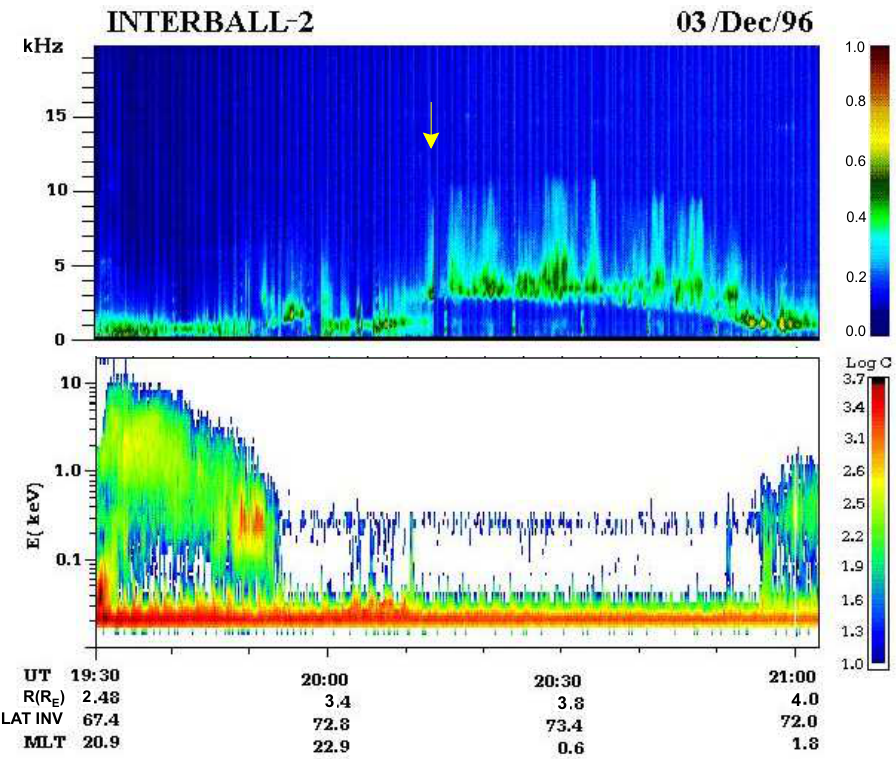
Fig. 2. INTERBALL-2 electron flux and VLF wave observations on 3 December 1996. Top panel: Spectrogram of the electric component of VLF emissions. The arrow marks the onset of auroral hiss near 20:13 UT on INTERBALL-2. Bottom panel: INTERBALL-2 electron energy-time spectrogram in the range 0.02–14keV. The electron counts rates C (counts/s) are color-coded. Appearance of auroral hiss on board INTERBALL-2 is situated well poleward from the auroral oval, and it correlates with the beginning of a weak localized magnetic bay at station SOR (Fig.